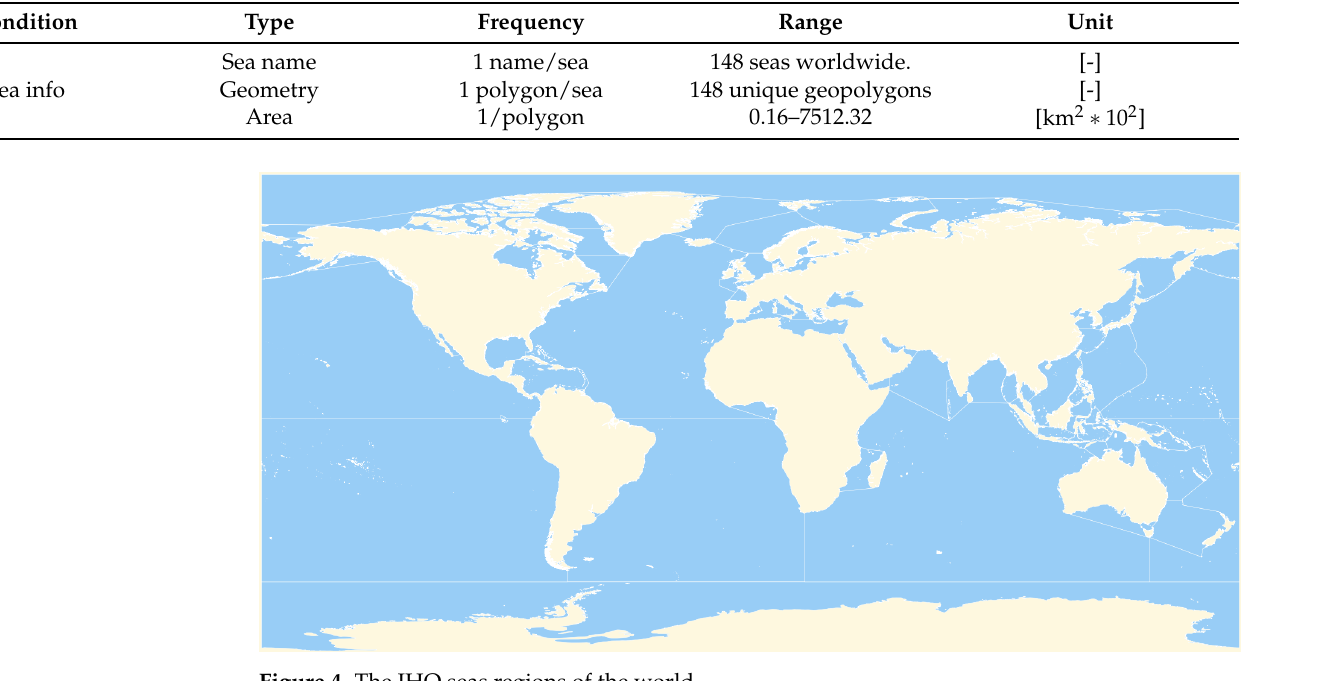
Figure 4. The IHO seas regions of the world.